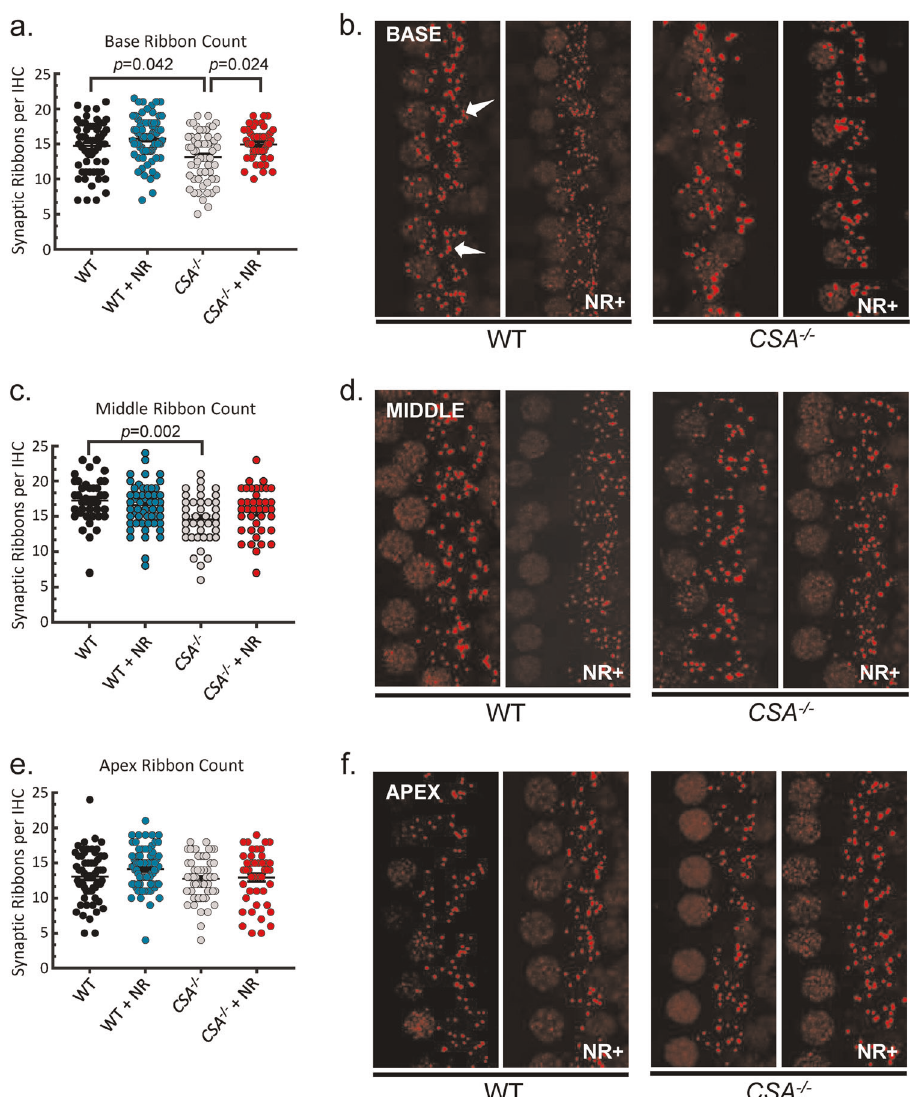
Fig. 6 NR enhances synaptic ribbon count per inner hair cell in the base region in CSA − / − mice cochlea. a , c , e The average synaptic ribbon count per inner hair cell in the cochlea base region ( a ), middle region ( c ), and apex region ( e ). The average number of ribbons is reduced in the base turn of the cochlea in CSA − / − mice relative to WT at 9 weeks of age. However, this effect is prevented by NR treatment. b , d , f Representative image of immunostaining for synaptic ribbons (red, anti-Ctbp2) of cochlear base segments ( b ), middle segments ( d ), and apex segments ( f ). A magni fi cation of 40× was used for all images that are oriented such that the base of each hair cell is located on the right side of the image. Hair cell nuclei, which are also labeled with anti-Ctbp2, are located on the left side. Each individual puncta represents a single synaptic ribbon (arrows). Fifteen cells per region per mouse are used for quanti fi cation; 24 mM NR in drinking water for 4 weeks was used for intervention ( CSA − / − ( N = 4); CSA − / − + NR ( N = 4); WT ( N = 4); WT + NR ( N = 5); mean ± S.E.; two-way ANOVA with Tukey ’ s post-hoc test was used to determine signi fi cant